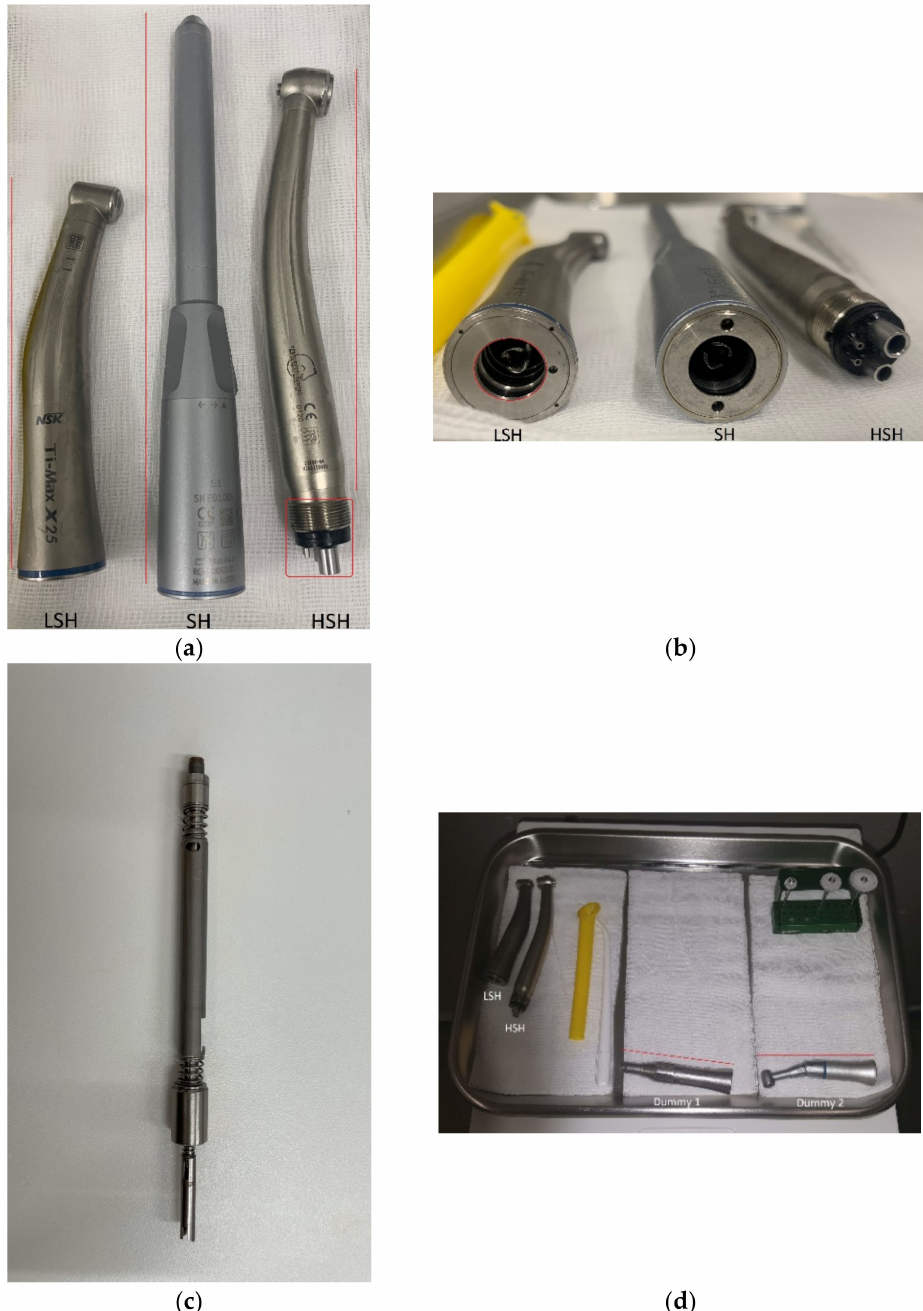
Figure 1. ( a ) Handpieces used for dental procedures in the study. LSH = Low-speed handpiece; SH = Surgical low-speed handpiece; and HSH = High-speed handpiece. Red lines indicate the external surface sampled of LSH, SH, and HSH. The red rectangle indicates the coupling surface sampled on HSH. ( b ) Handpieces used for dental procedures in the study. The red circle indicates the coupling of which the first 0.5 cm was sampled in LSH. ( c ) Shaft of SH; the red line indicates the surface sampled. ( d ) Some of the dental devices used in the study. The red lines indicate the external surface sampled on dummy 1 and